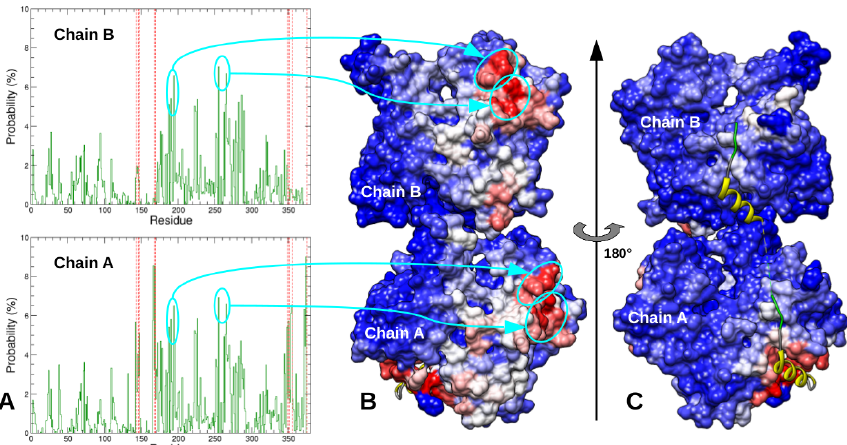
Figure 10. ( A ) Residue-specific probability of actin dimer chain A (bottom) and chain B (top) to be distant by less than 4 Å from N-WASP domain V regions 9–18 or 37–46 in the ensemble of 7540 ternary complexes generated by docking. Red dashed lines indicate the actin residues in contact with the N-WASP helical segment in the X-ray structure 2VCP [27]. ( B , C ) Back and front views of the actin dimer surface colored proportionally to the previous probabilities. Blue, white, and red colors indicate actin residues with low, intermediate, and high probabilities to be contacted by N-WASP domain V regions 9–18 or 37–46, respectively. As a reference, yellow and green ribbons represent helical regions and consensus sequences “LKKV” of the two WH2 motifs observed in the X-ray structure 3M3N [26].